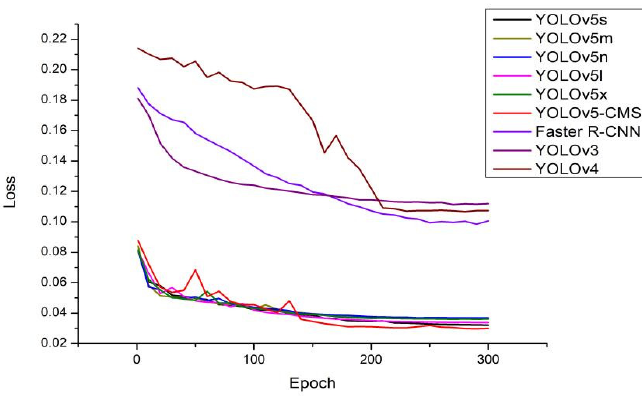
Figure 8. Comparison of loss values.